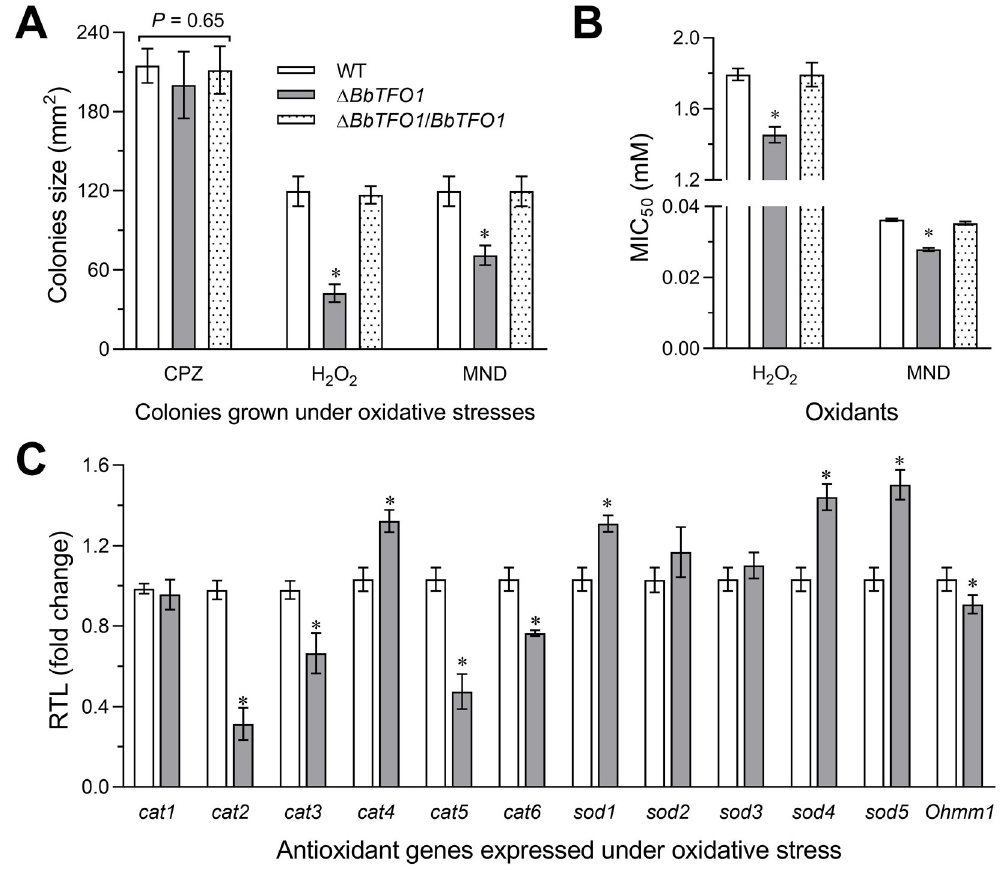
Fig 2. Disruptions to BbTFO1 affect OS resistance and antioxidant-related enzyme gene expression in B . bassiana . (A) Colony size was measured on the seventh day of culture at 25˚C after inoculation. (B) MIC 50 estimates for two oxidants (H 2 O 2 and menadione) to inhibit 50% fungal growth in diverse strains on CPZ at 25˚C. (C) Relative antioxidant-related gene transcript levels of Δ BbTFO1 strains compared with WT cultured for 5 days at 25˚C on CPZ containing H 2 O 2 (2 mM). The bar marked with an asterisk in each group shows a significant difference (Tukey’s HSD, P < 0.05). Error bars: SD of 3 repeated assays.